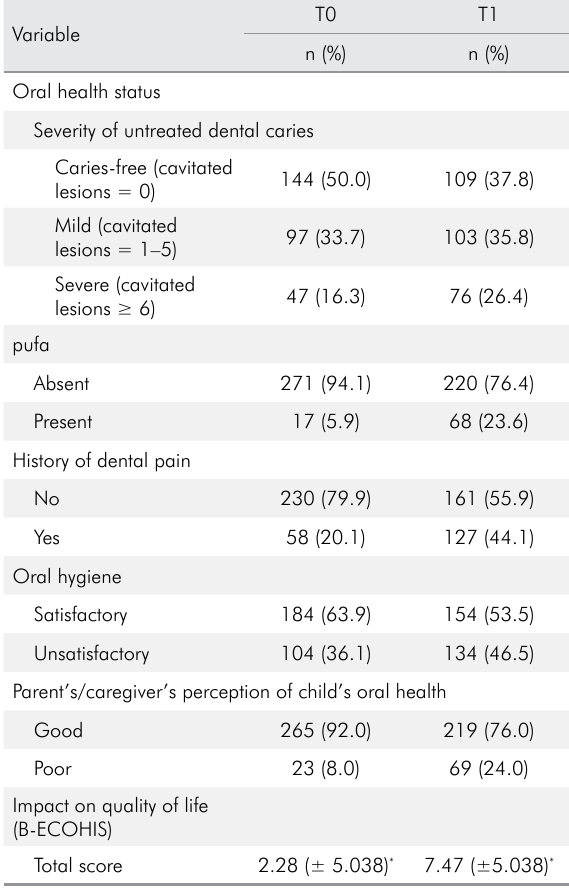
Table 1. Frequency distribution of preschool children (n = 288) according to oral health status at baseline (T0) and second examination